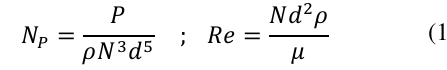
Fig. 2. Schematic diagram of the Novel impeller (top